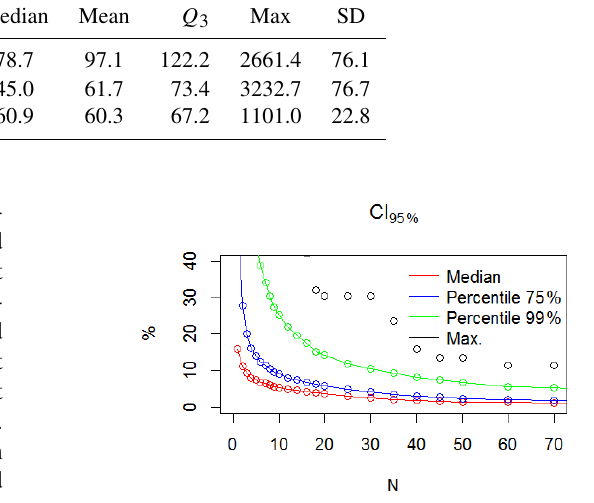
Figure 10. Variation in the 95% confidence interval of the arith- metic mean according to the sample size ( N